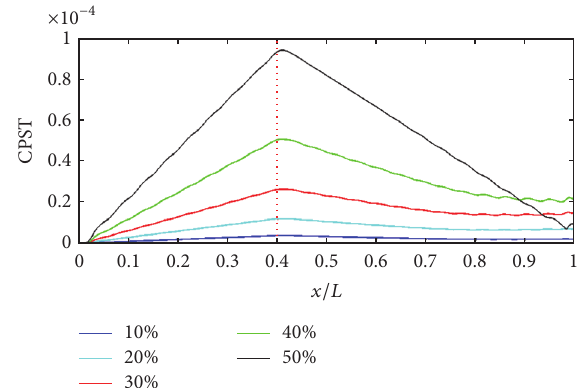
Figure 15: CPST of 10% damaged scenario using displacement responses with the mass which is 50 Kg.